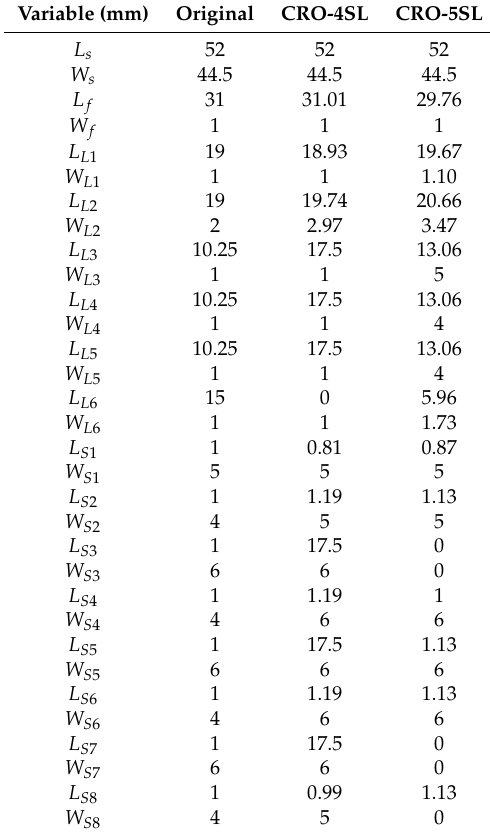
Table 3. Antenna dimensions after the optimization process with CRO-4SL and